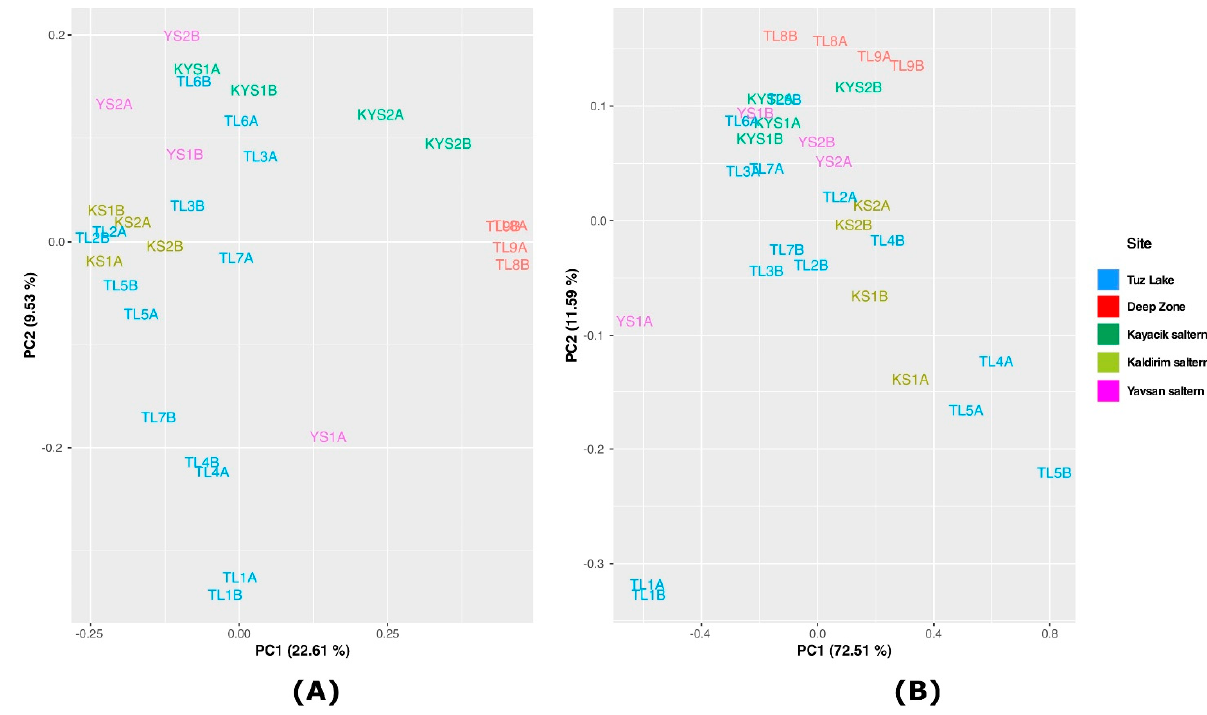
Figure 4. Principal components analysis (PCA) of the brine samples of Tuz Lake, Deep Zone, and Kayacik, Kaldirim, and Yavsan salterns. ( A ) Unweighted UniFrac, ( B ) Weighted UniFrac.